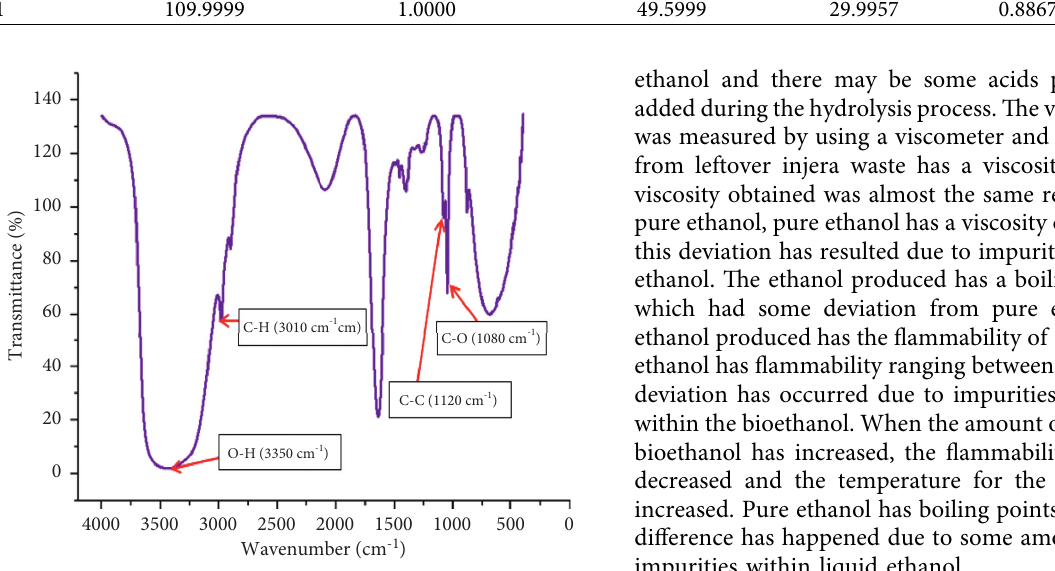
Figure 5: Functional group analysis for ethanol by using